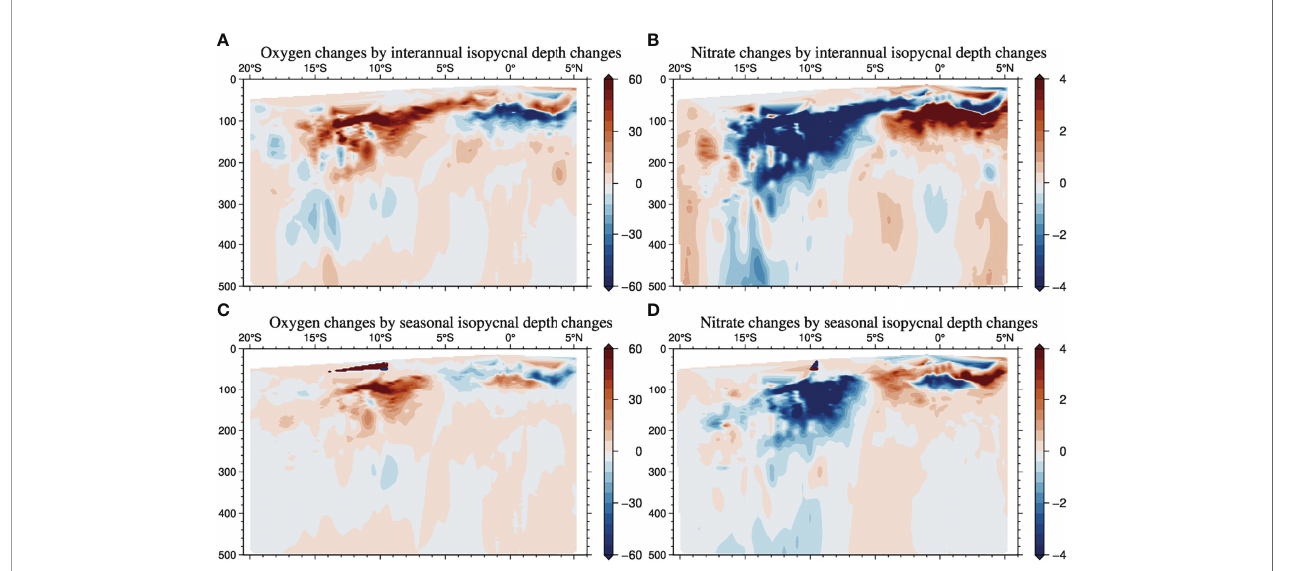
FIGURE 11 | Effects of the interannual isopycnal depth anomalies on the changes in DO (A) and nitrate (B) in December 2019 and effects of the seasonal isopycnal depth anomalies on the changes in DO (C) and nitrate (D) in December from the annual mean. The effects were estimated by multiplying the anomalies (from the monthly climatology and annual mean which are calculated monthly gridded data in 2006 – 2020) in interannual and seasonal isopycnal depths calculated with the Argo gridded dataset (ex. interannual anomalies are shown in Figure 8 ) by the vertical gradient of DO and nitrate ( Figure 4 ), assuming that long-term mean distributions of DO and nitrate on isopycnal surfaces were similar to those obtained by the cruise in